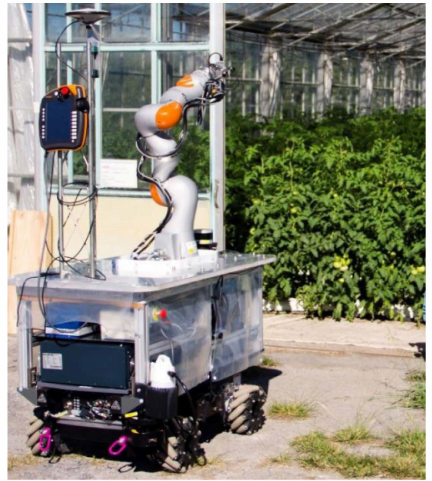
Figure 13. GreenPatrol robotic platform entering a greenhouse